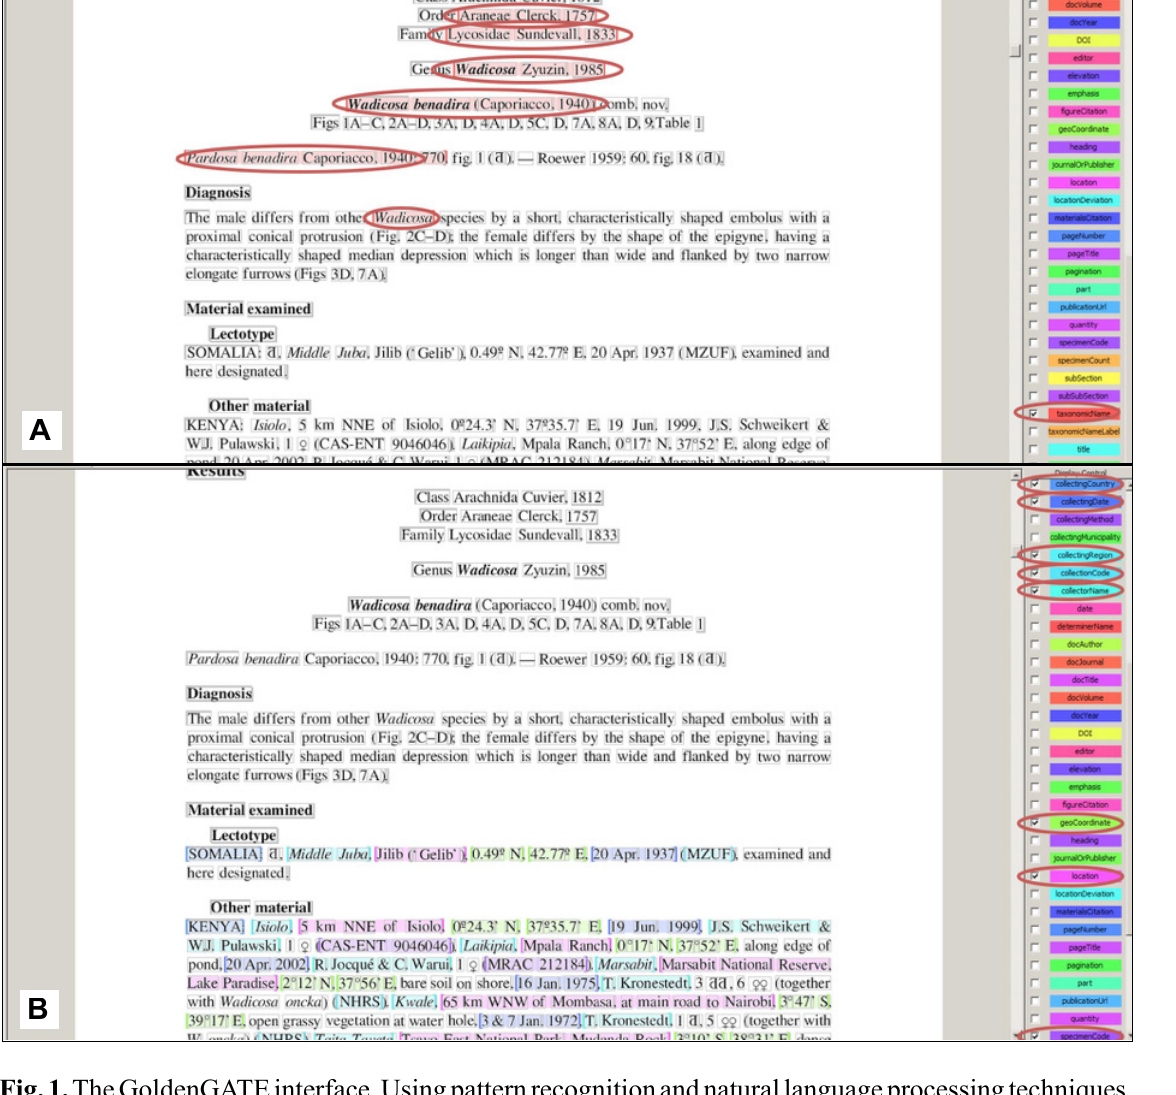
Fig. 1. The GoldenGATE interface. Using pattern recognition and natural language processing